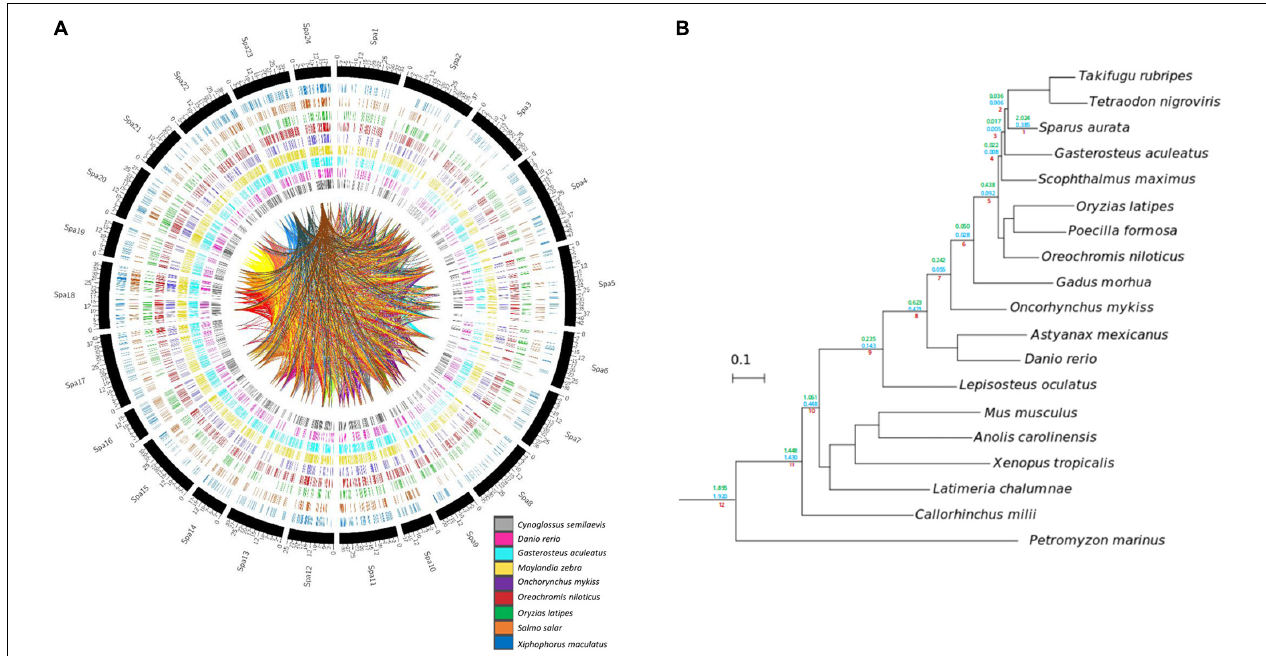
FIGURE 4 | Gene homology and phylogeny of gilthead sea bream. (A) Circos plots representing homology relations between gilthead sea bream and other fish species genes. Relations between scaffolded genes with other species with a 99% of identity are shown. Duplicated genes relations between gilthead sea bream chromosomes are represented by inner lines. (B) Species tree obtained from the concatenation of 148 single-copy widespread proteins. All nodes are maximally supported (1 aLRT). Number on the branches mark the duplication densities (average number of duplication per gene and per lineage) for gilthead sea bream genes in the lineages leading to this species with (green) or without (blue)